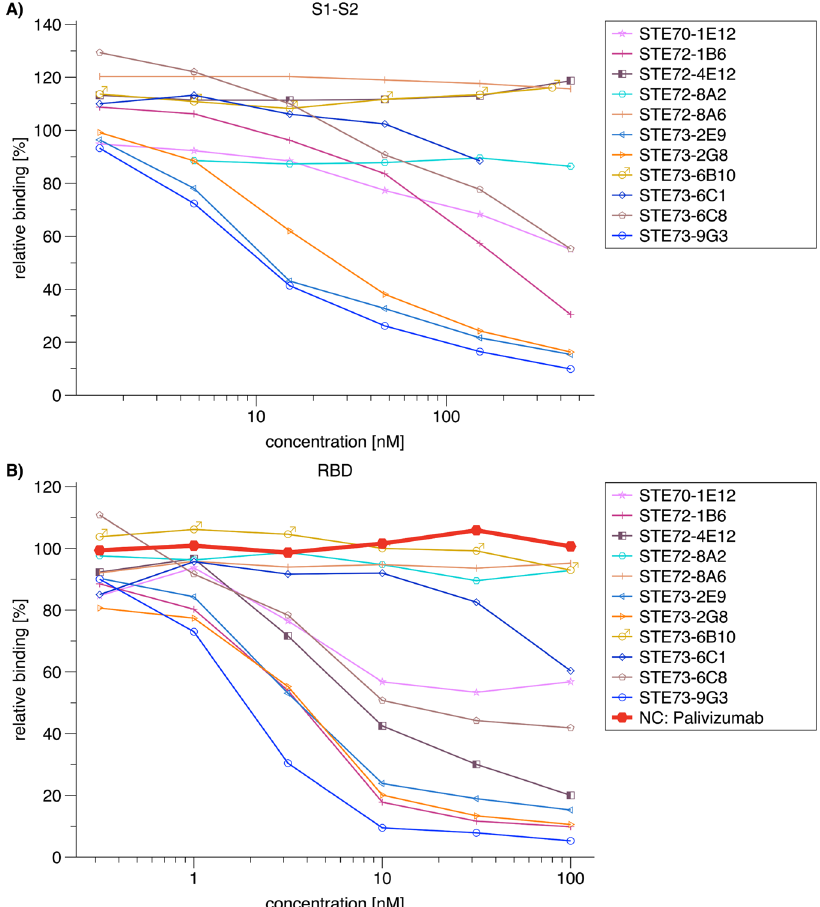
Fig. 5 Inhibition of RBD – ACE2 interaction by IgG. A IC50 determination by fl ow cytometry using 50 nM S1-S2-His and 0.5-500 nM IgG. B IC50 determination by fl ow cytometry using 10 nM RBD-mFC and 0.1 – 100 nM IgG. Palivizumab was used as negative control. The inhibition assays were made as single titrations. Logistic5 fi t of Origin was used to determine the